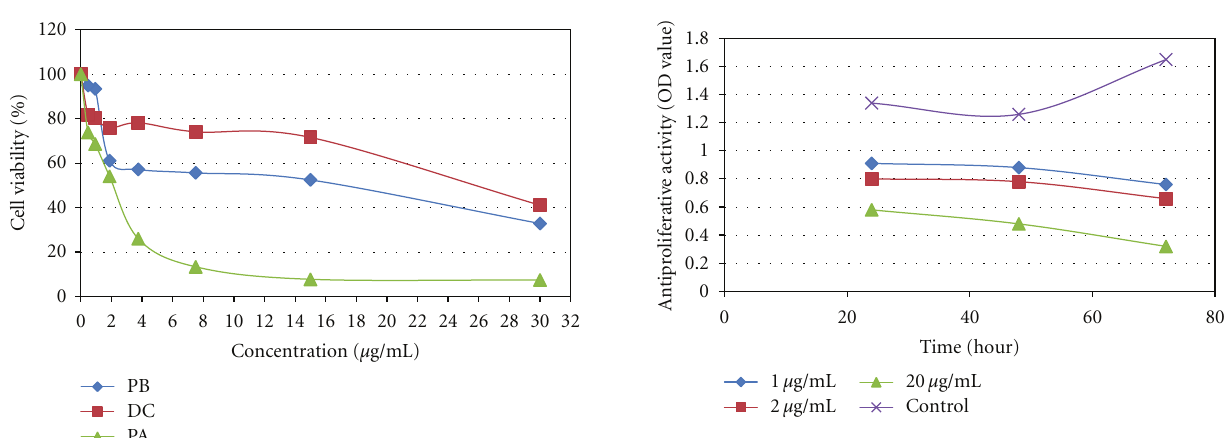
Figure 5: E ff ect of pyranocycloartobiloxanthone A ( 1 ) on the proliferation of HL60 cells in vitro . After treatment with 1 μ g/mL, 2 μ g/mL (IC 50 based on MTT results) and 20 μ g/mL for 24, 48, and 72 hours cellular proliferation of HL60 cells was assayed using BrdU incorporation ELISA.